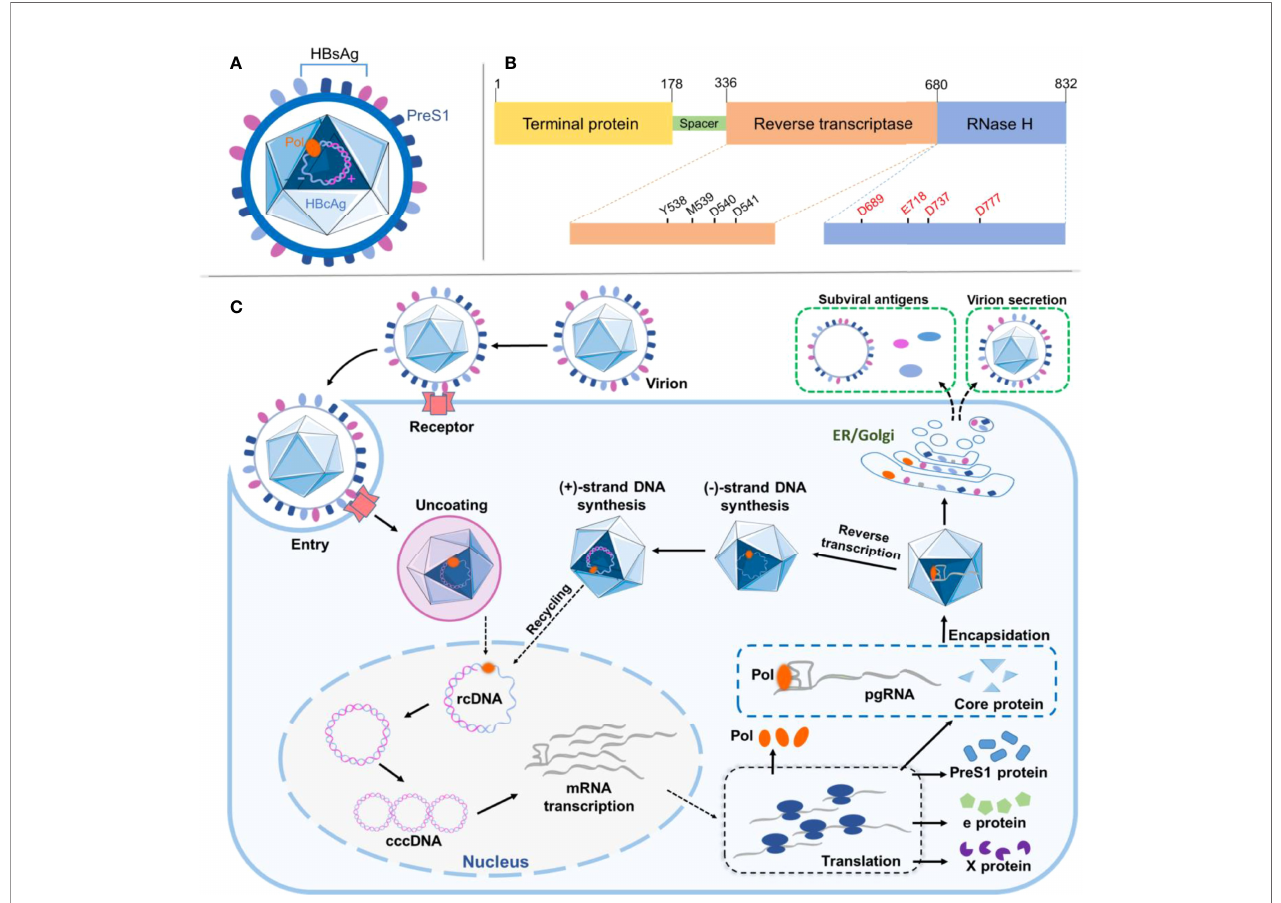
FIGURE 1 | Viral structure and protein domain of HBV and its life cycle in the host. (A) Illustration of HBV particle with structural features as indicated and discussed in the text. (B) Depiction of HBV multifunctional domains where critical residues and motifs are indicated. (C) Schematic illustration showing HBV infection and replication in the host cell. All steps are as indicated and discussed in the text. HBV, hepatitis B